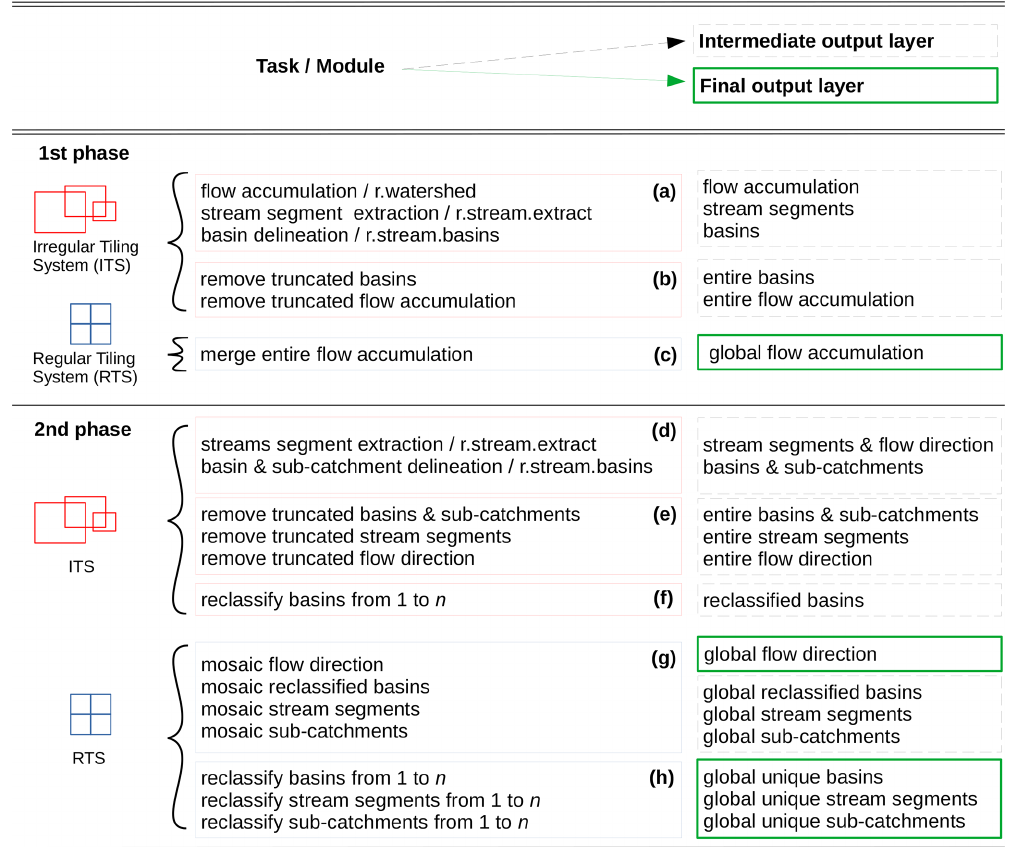
Figure 4. Overview of the Hydrography90m dataset computation workflow. Task labels correspond to the performed computation, and command labels refer to the GRASS GIS module used. The parenthesised letters listed in the figure correspond to steps detailed in the methodology section. A schematic scripting procedure of the workflow for three South American tiles is reported at http://hydrography.org (last access: 5 October 2022). The scripting procedure is related to the first and second phases but without the final reclassification step to have a simplified workflow